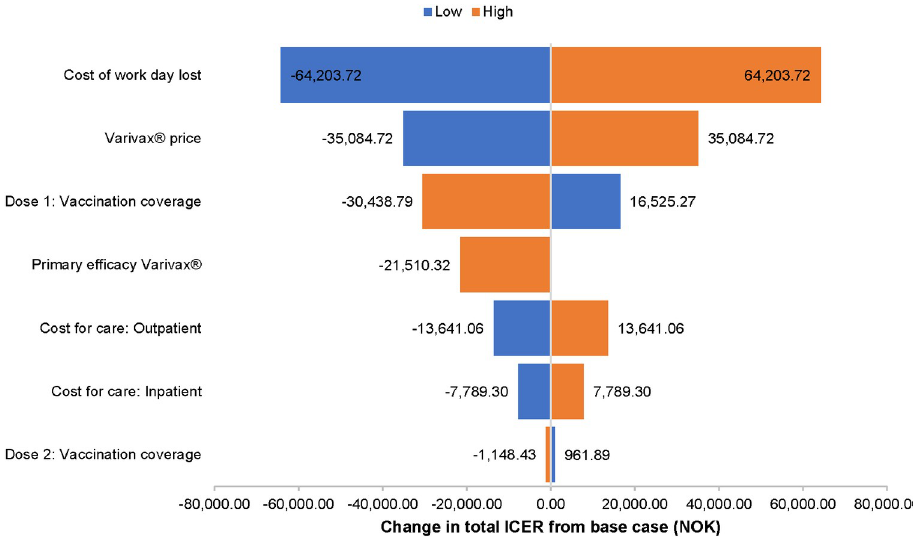
horizon, all strategies are projected to reduce outpatient cases and hospitalizations by 67% to 85%, and deaths by 75% to 79%. A varicella vaccination program in Norway under all mod- elled strategies would be cost saving compared to no vaccination from the perspectives of both the healthcare system and society. From the societal perspective, most of the projected cost savings are due to reductions in lost workdays. Among the vaccination strategies, those with two doses of V-MSD, with the second dose at 18 months or 7 years (strategies E and A,